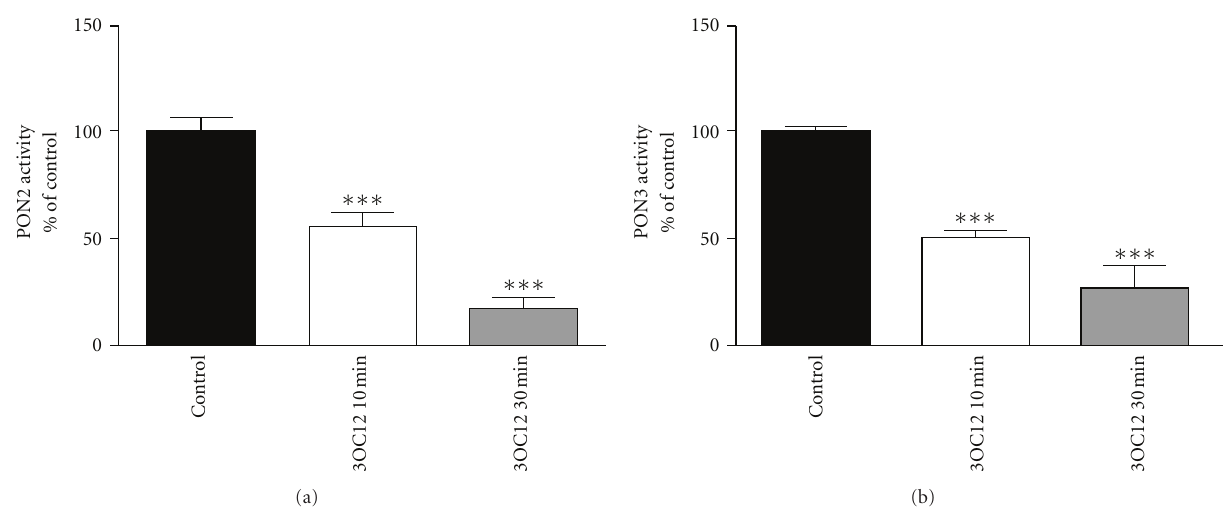
Figure 4: PON2 and PON3 activity decrease after 3OC12 treatment. (a) PON2-GFP overexpressing HEK293 cells were treated with 3OC12 (100 μ M) for the indicated durations and tested for 3OC12-HSL hydrolytic activity. (b) PON3-GFP overexpressing HEK293 cells were treated with 3OC12 (100 μ M) for the indicated durations and tested for lovastatinase hydrolytic activity. Symbols represent ± S.E.M. n = 3; ∗∗∗ P < 0 . 001.